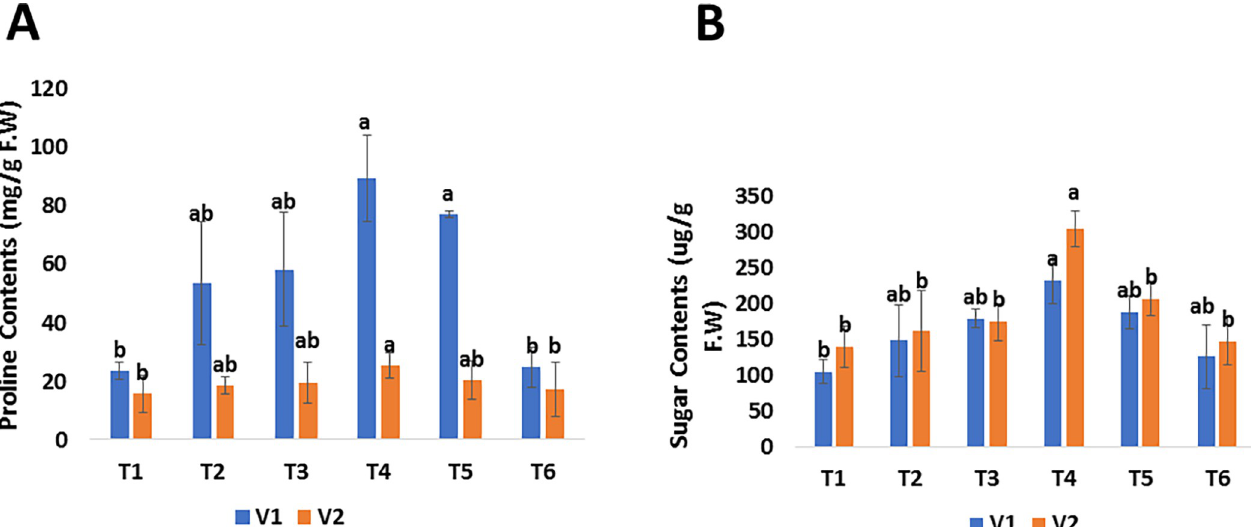
Fig 7. Effect of foliar applications of green synthesized SeNPs on biochemical parameters of Mangifera indica under the stress of mango malformation disease. (A) Proline contents of M . indica in response to different treatments of SeNPs. (B) Sugar contents of M . indica in response to different treatments of